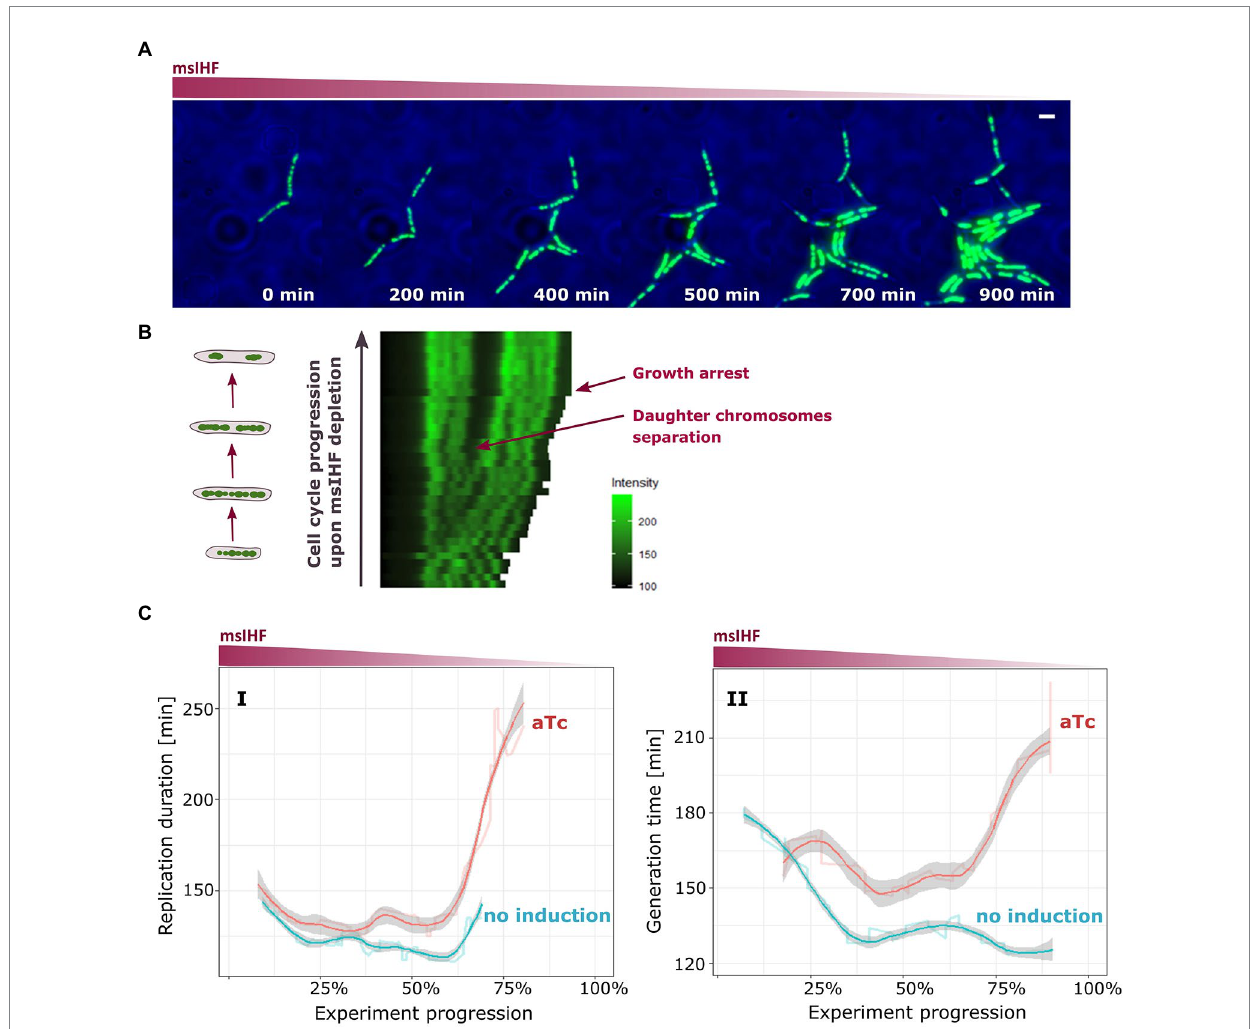
FIGURE 5 Influence of msIHF depletion on chromosome organization, replication, and segregation dynamics in M. smegmatis . (A) Time-lapse experiment of HupB-EGFP/IHF strain showing nucleoid shrinkage after induction of dCas9 with 50 ng/ml aTc. Scale bar, 2 μ m. (B) Kymograph of representative cells of HupB-EGFP/msIHF ↓ strain upon aTc induction. (C) Charts present average replication time ( I ; duration of chromosome replication) and generation time ( II ; time between two subsequent oriC doubling events) in DnaN-mCherry/msIHF ↓ and ParB-mCherry/msIHF ↓ strains during the progression of TLMM experiments (i.e., moving average). DnaN-mCherry/msIHF ↓ and ParB-mCherry/msIHF ↓ strains were induced with 50 ng/ml of aTc and compared to the corresponding strains grown without inductor (i.e., the native msIHF